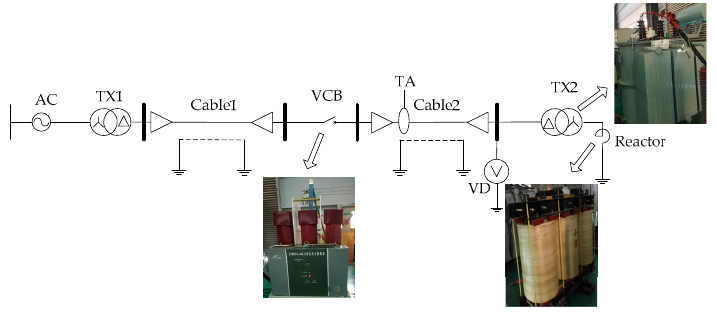
Figure 5. The test system wiring diagram.